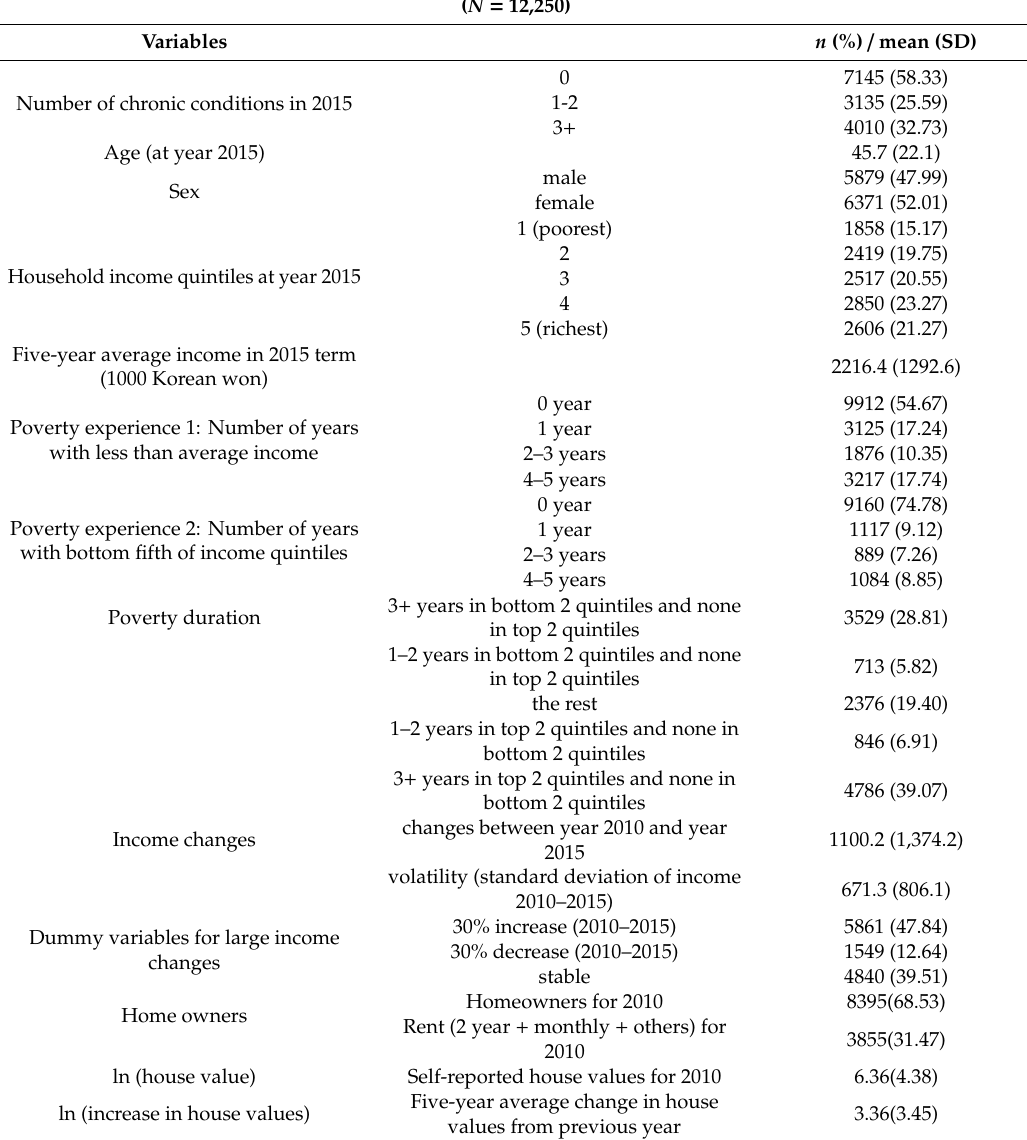
Table 1. Summary statistics on Korea Health Panel